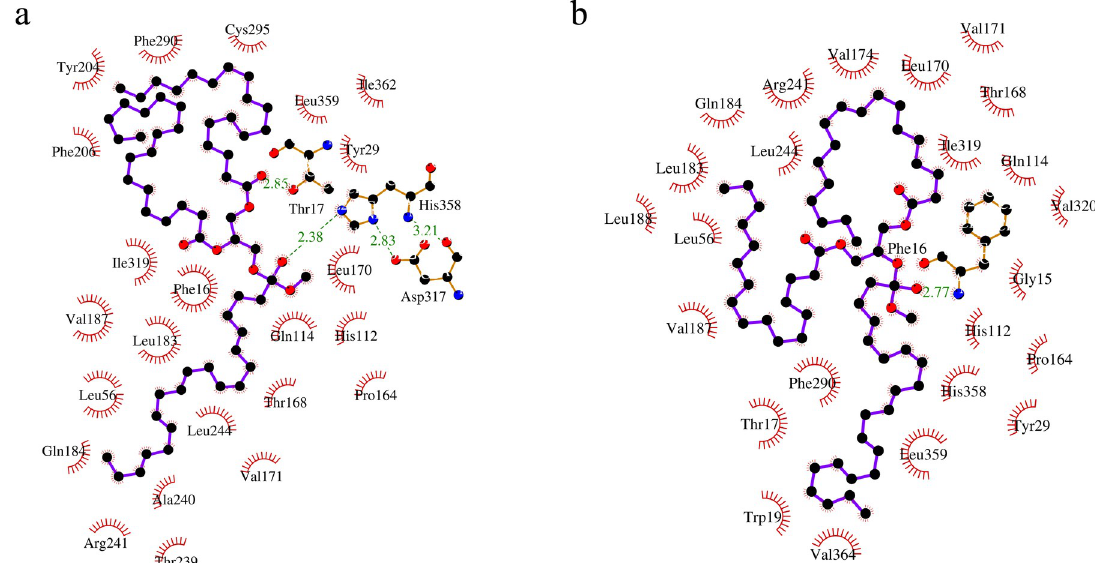
Fig 1. Amino acids interacting with triglyceride during hydrolysis as observed by covalent docking. (a) Representative Substrate 1 has EPA at sn-1 position and (b) Representative Substrate 2 has DHA at sn-2 position. Other positions are occupied by octadecanoic acid and 9-octadecenoic acid. Docking was performed using AutoDock Vina and the figure was generated using Ligplot [45].